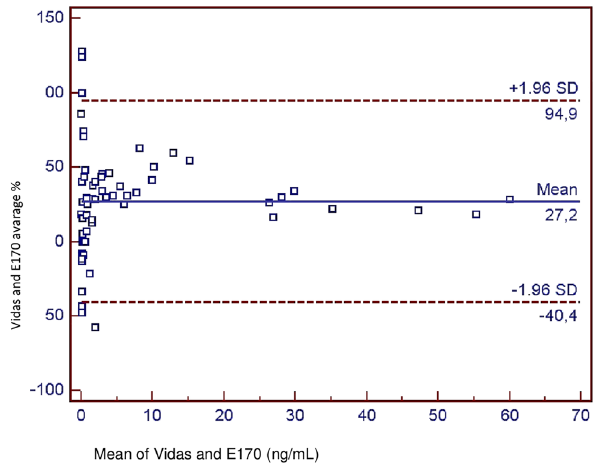
Figure 3: Bland – Altman graphic for measurement results of E170 and VIDAS.